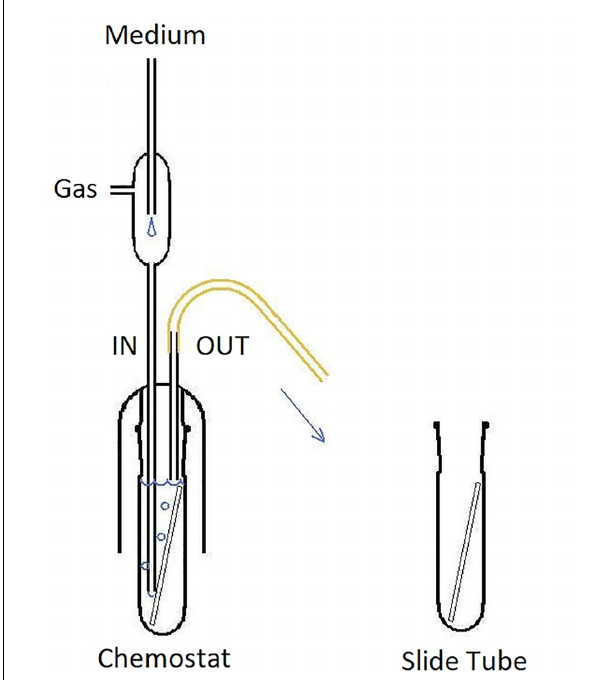
FIGURE 2 | Design of the glass chemostat tank. IN, inflow tubing reaching close the bottom of fermenter; note the flow interrupter assembly mixing sterile medium that drips through the space protected with HEPA-filtered gas flow. OUT, overflow tubing (keeping a constant fluid volume of the chemostat). Slide Tube, container allowing aseptic exchange of the chemostat contents including the biofilm slide.